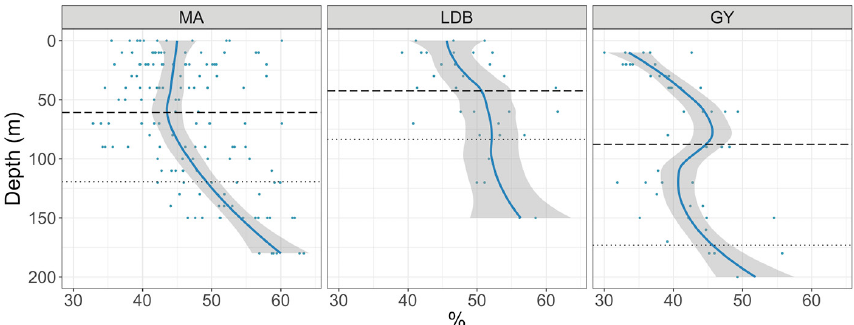
Figure 5. Percent of total bacteria accounted for by HNA, by biogeochemical region: MA, LDB, and GY. Trendline calculated using LOESS regression. Shading represents the standard error of samples at each depth. The dashed line represents the average PAR 2 . 7 depth. The dotted line represents the average PAR 0 . 1 depth. Table 3. Average depth-integrated concentrations of 19 (cid:48) -hexanoyloxyfucoxanthin (19 (cid:48) HF) and 19 (cid:48) -butanoyloxyfucoxanthin (19 (cid:48) BF). Ratios of these pigments to Chl a calculated using HPLC values for T Chl a . cond.